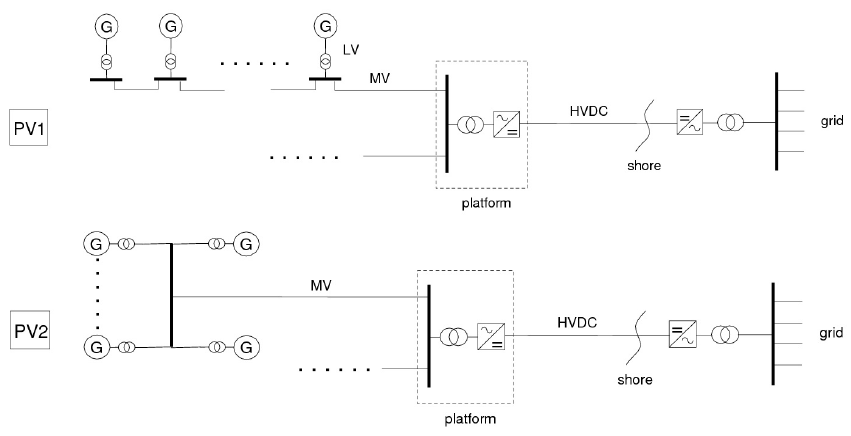
Figure 8 . Park-coupled variable-speed system with HVDC